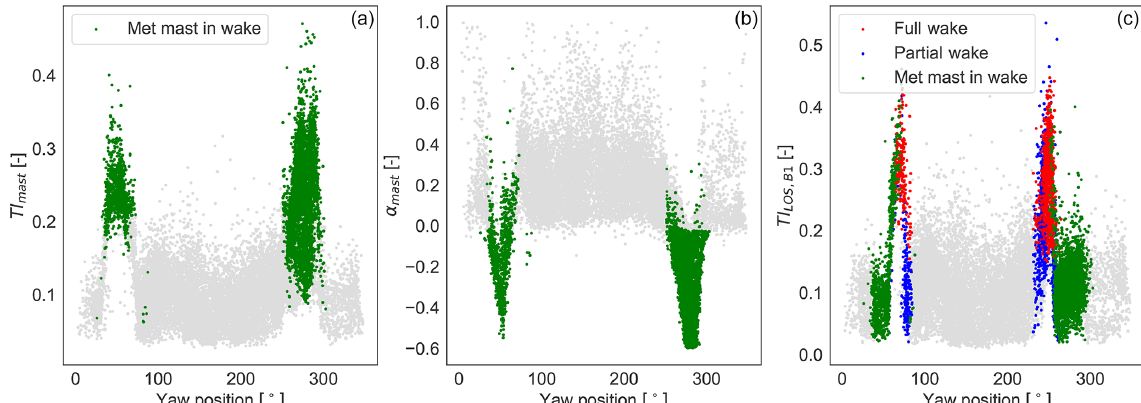
Figure B1. (a, b) The 10min observations of the turbulence intensity and vertical wind shear at the mast as a function of turbine yaw position. Free-wind conditions relative to the mast are identified with grey markers, and waked situations are identified with green markers. (c) PL-estimated 10min wake detection parameter TI LOS , B1 . Detected wake situations of turbine T04 are shown with coloured markers: wake-free (grey), partial-wake (blue), and full-wake (red) conditions. The 10min periods when the mast is affected by wakes are shown as green